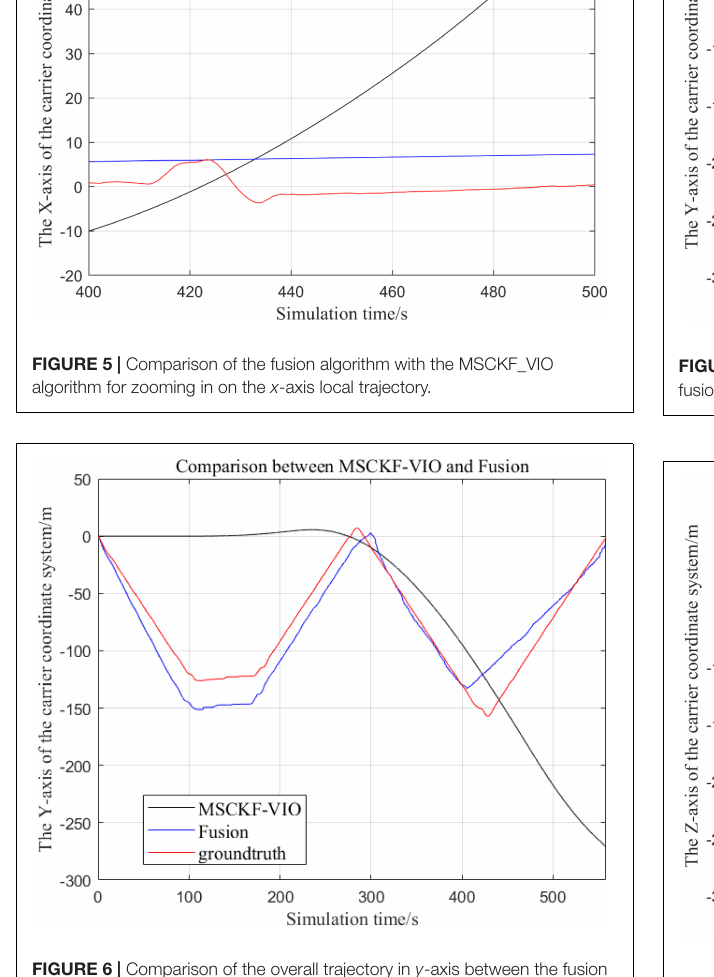
FIGURE 8 | Comparison of the overall trajectory in z -axis between the fusion algorithm and MSCKF_VIO